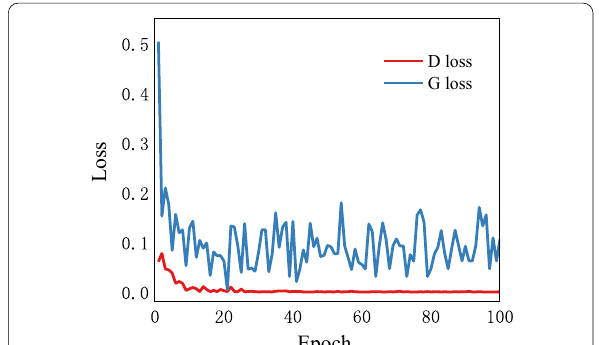
Fig. 4 Training loss of discriminator and generator